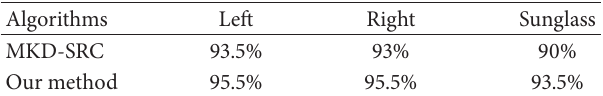
Table 3: Results of the fourth